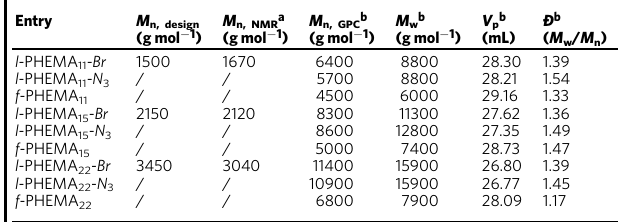
a Determined by 1 H NMR. b Determined by GPC using DMF as eluent and PMMA as